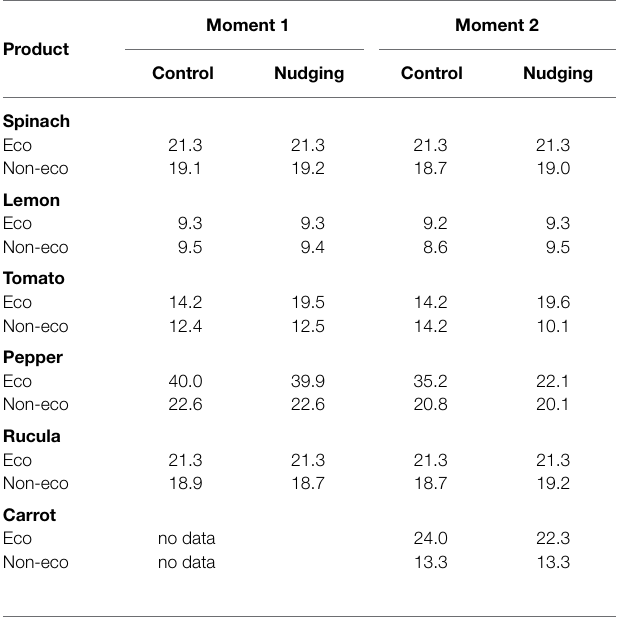
TABLE 3 | Percentage of eco products sold (tomatoes and pepper) and the relative price (non-eco alternative = 1), for each condition (control and nudging), in the first or the second period of the